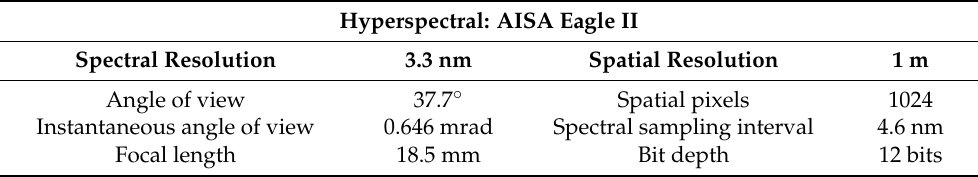
Table 2. Parameters of the hyperspectral sensors in the LiCHy